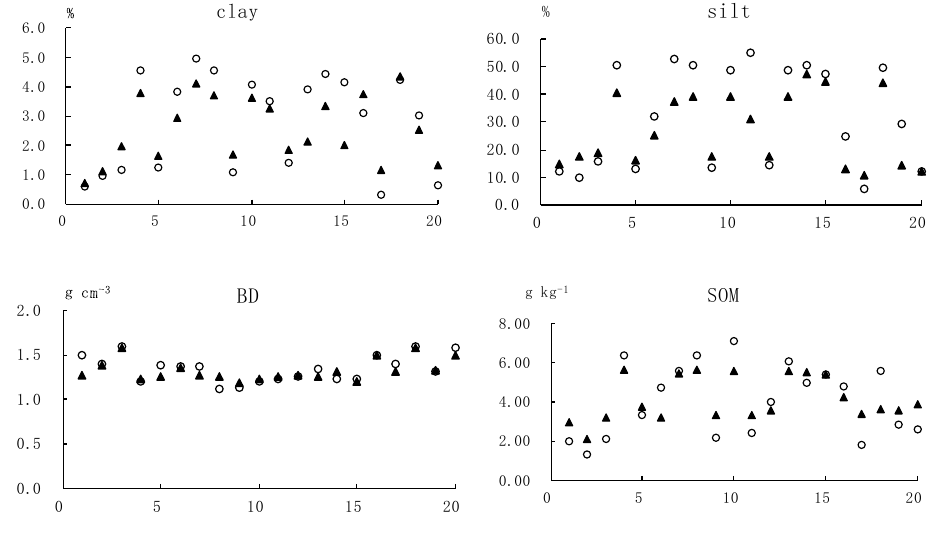
Table 6. Stepwise multiple regression function for each soil property.